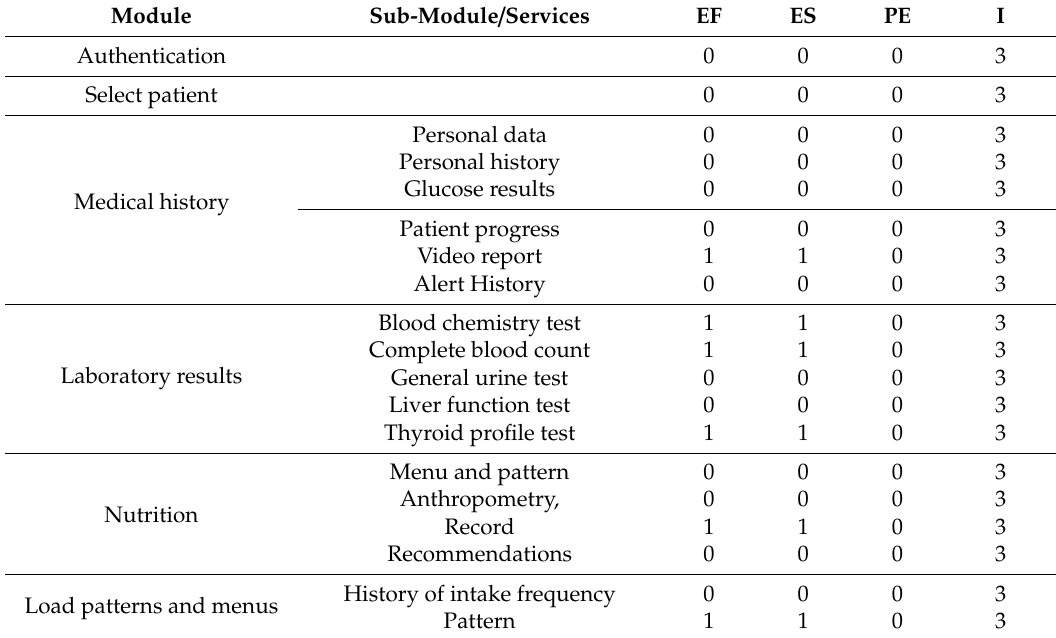
Table 2. Summary test of the services of the web application for health personnel. (EF) errors found, (ES) errors solved, (PE) pending errors, and (I)